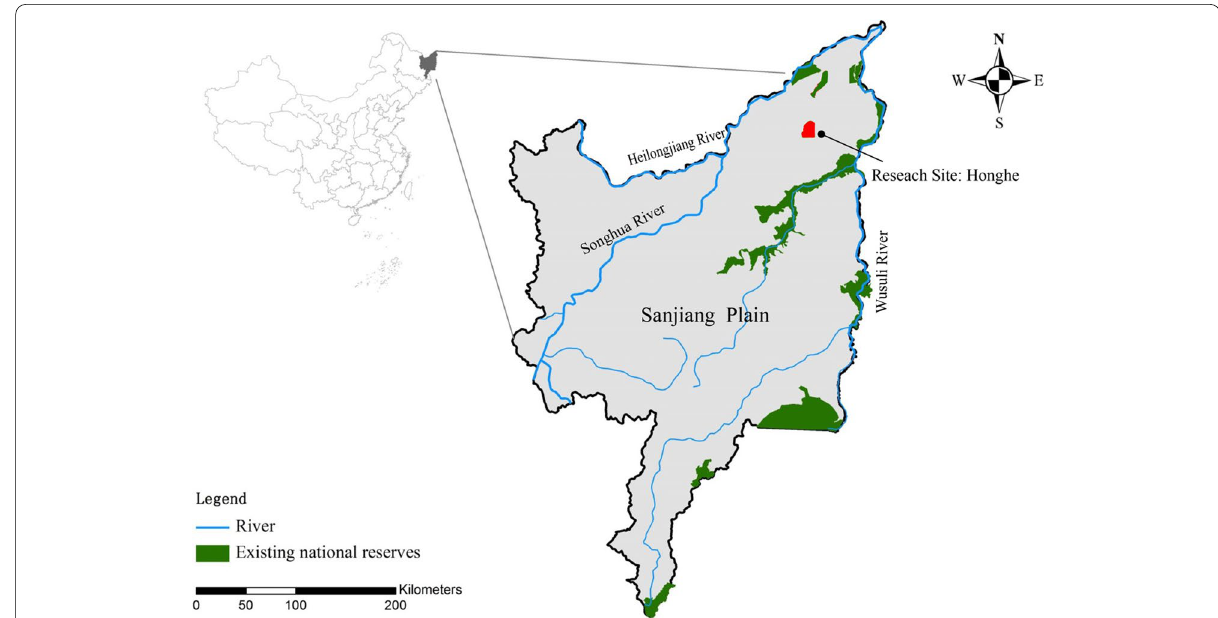
Fig. 6 Location of the research site (Honghe National Nature Reserve, Sanjiang